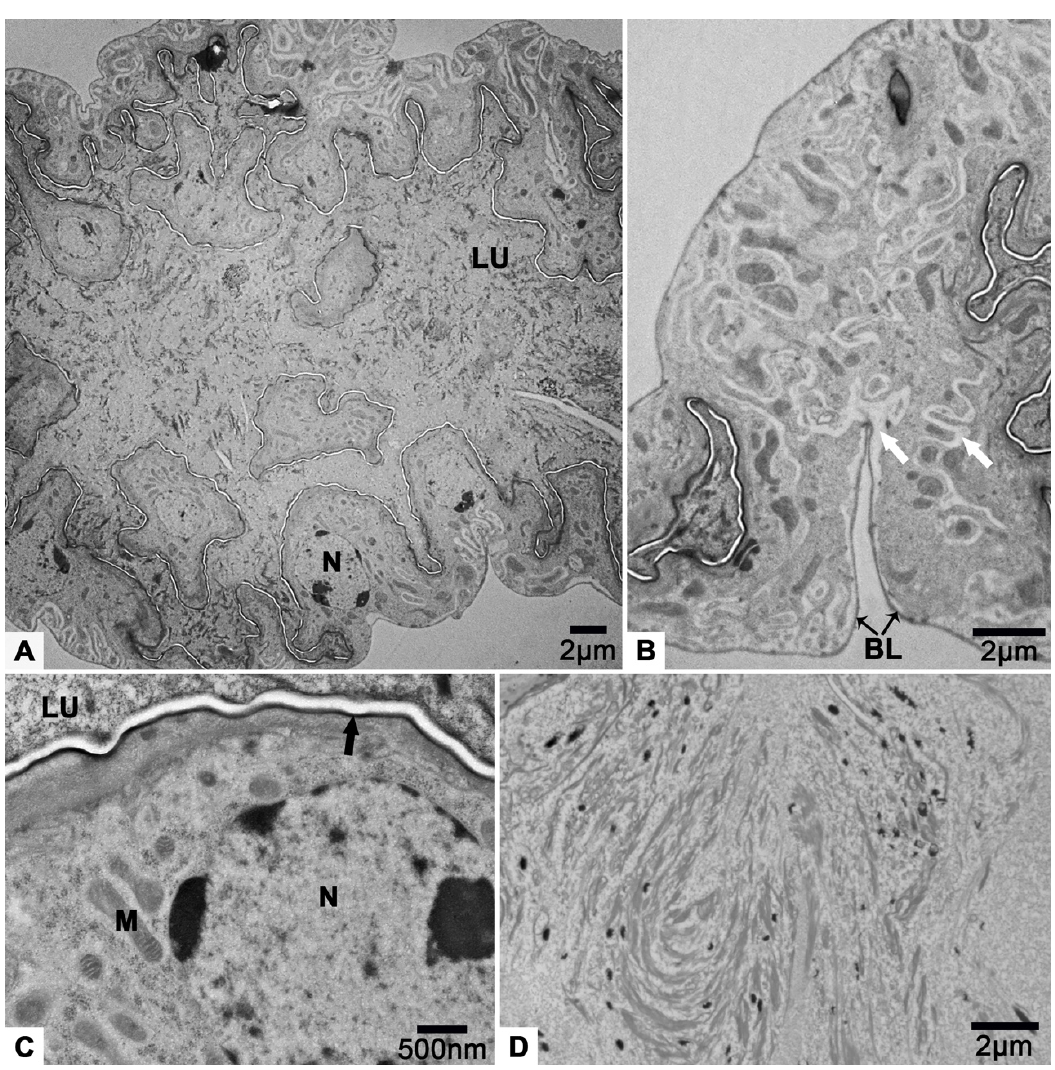
Figure 12. TEM micrograph of accessory gland of T. klimeschi on sixteenth day post-eclosion. ( A ) Cross section of the accessory gland. ( B ) The intercellular spaces (white arrows). ( C ) The inner surface of accessory gland (black arrow). ( D ) The flocculent substances in the lumen. Lumen (LU); mitochondria (M); nucleus (N); and basal lamina (BL).